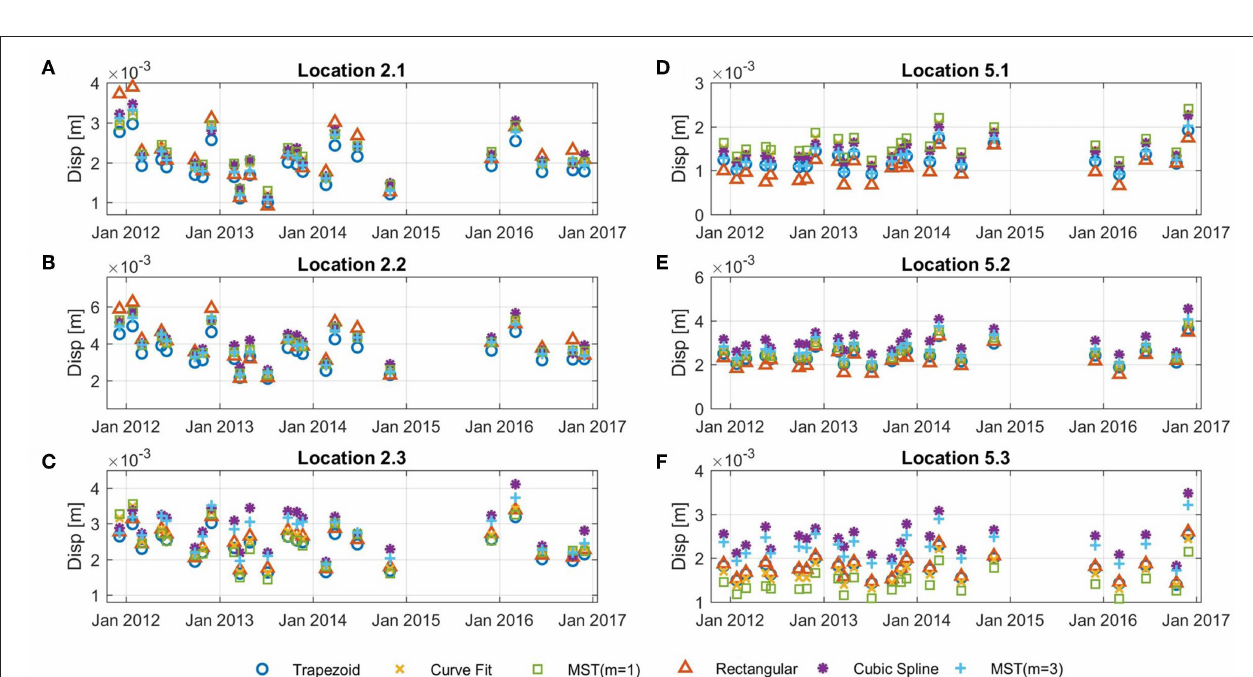
FIGURE 14 | The maximum displacements for each sensor location on girder 2 at the quarterspans (A,C) and midspan (B) and on girder 5 at the quarterspans (D,F) and the midspan (E) .